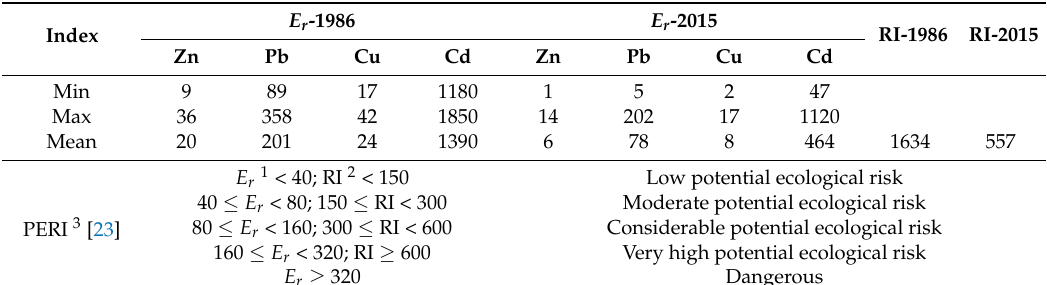
Table 3. PERI (potential ecological risk index) of Zn, Pb, Cu, and Cd in topsoil (0–20 cm) of SD village between 1986 and